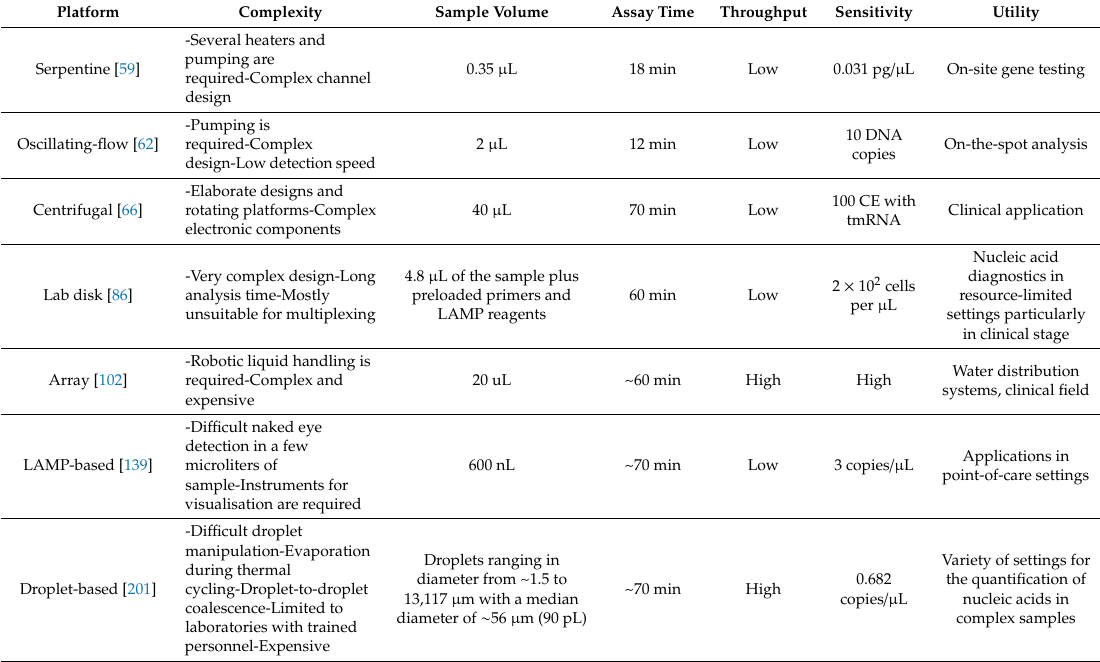
Table 4. Merits and demerits of microfluidic-based amplification